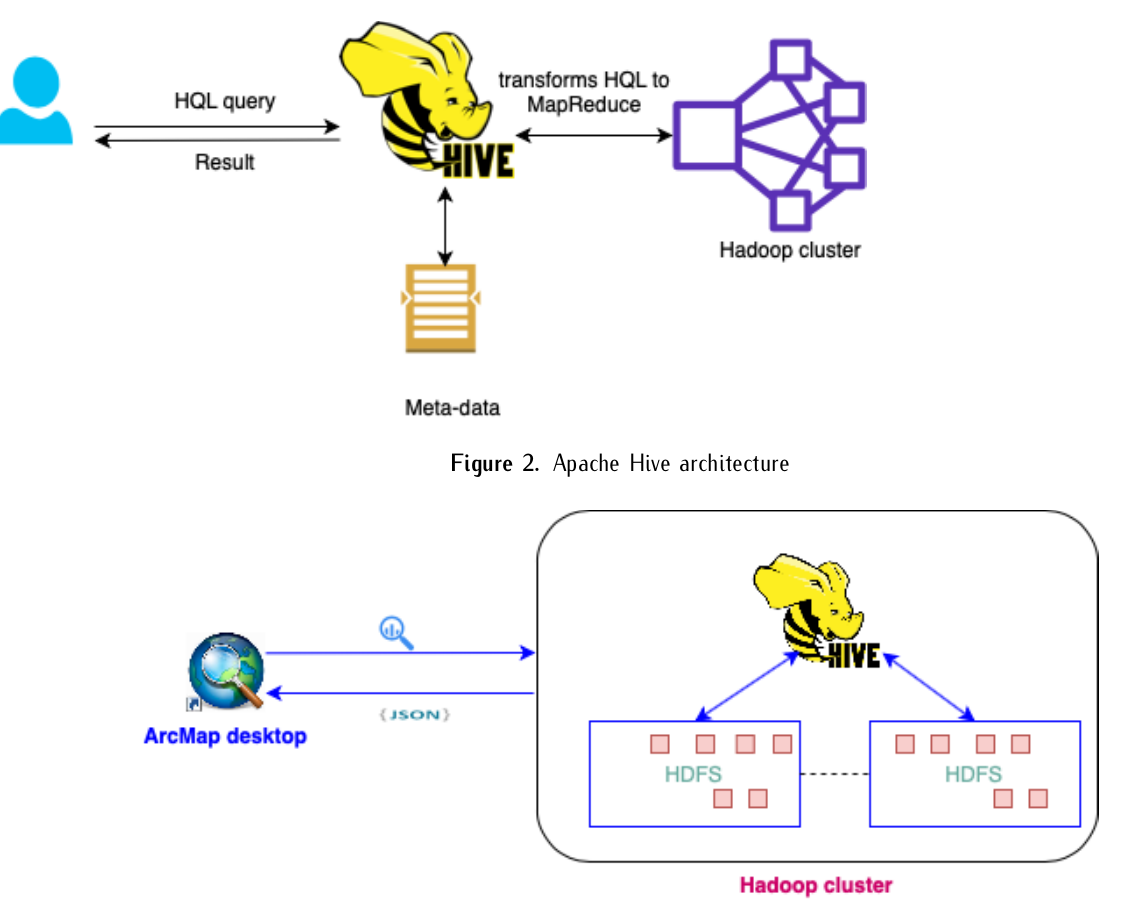
Figure 3. Integration between ArcMap and Hive Table 1. Taxi trips data in 12